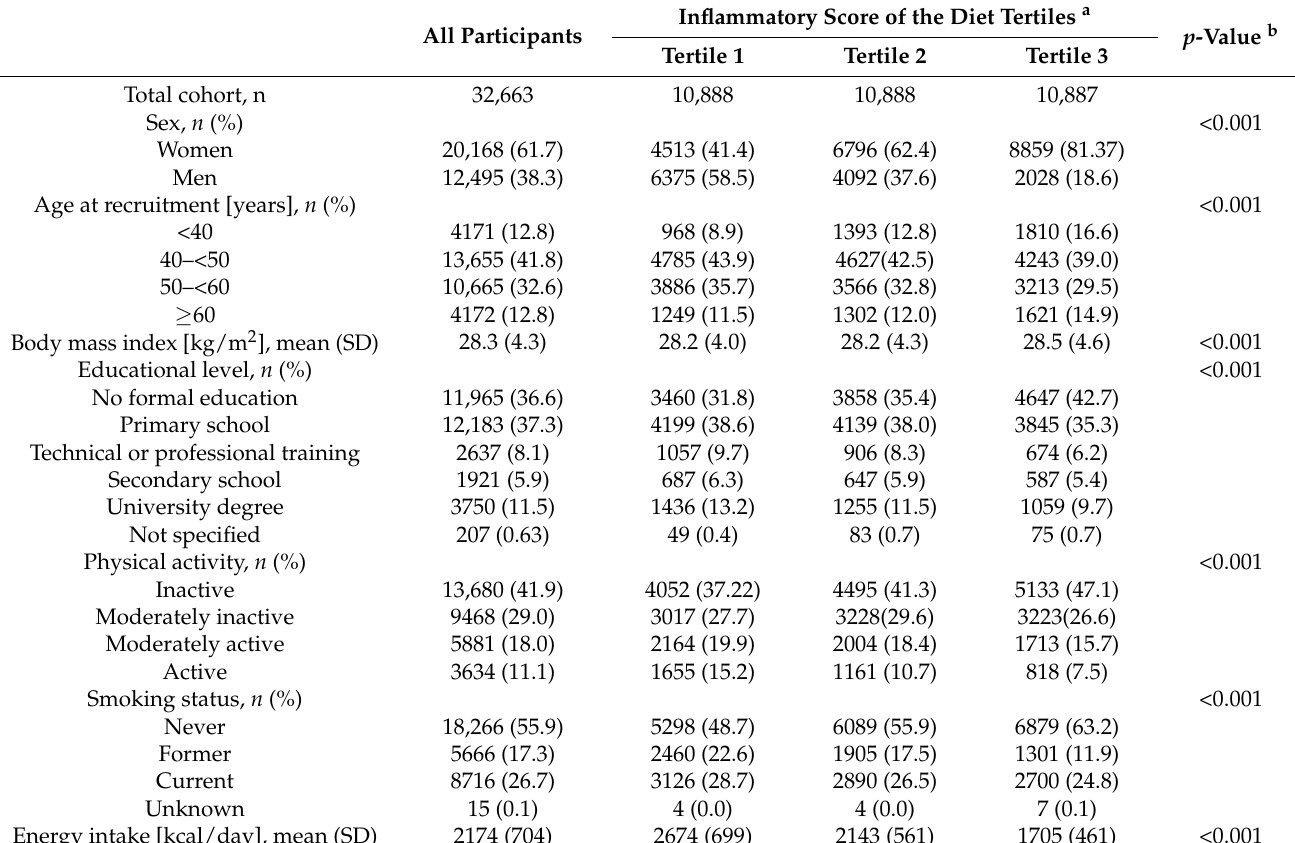
Table 1. Baseline characteristics of the study participants according to tertiles of the Inflammatory Score of the Diet (ISD). All